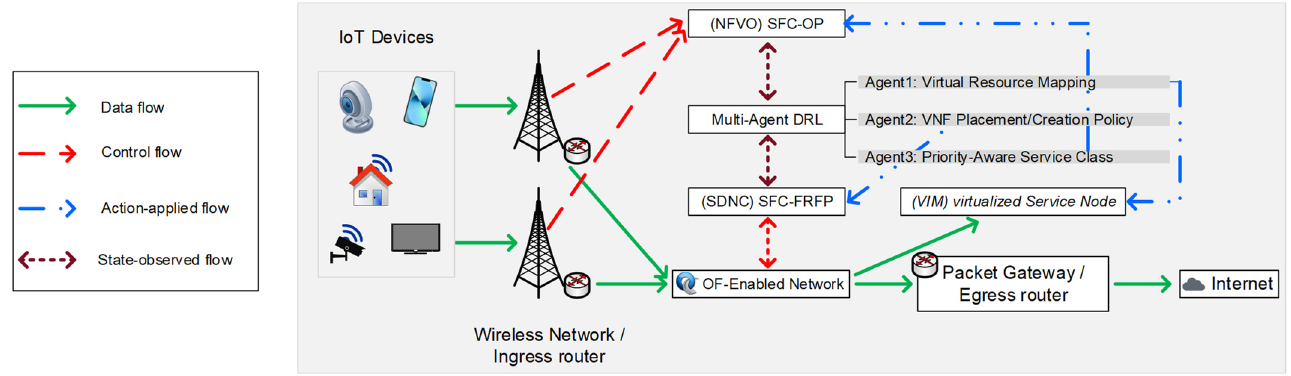
Figure 3. Interaction between SDN/NFV-assisted SFC systems and proposed agents.